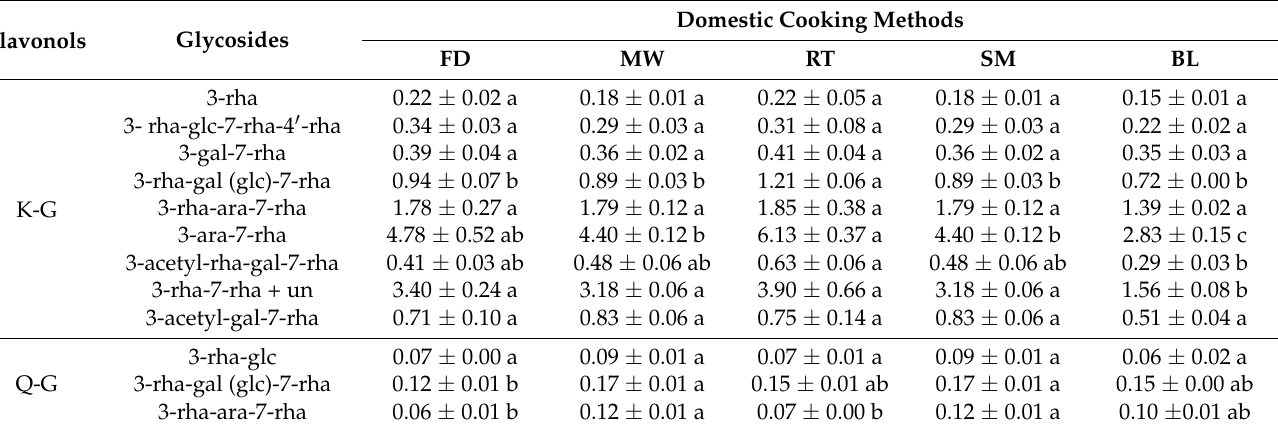
Table 2. Effect of domestic cooking on faba leaf flavonoid (flavonol) glycosides (mg of kaempferol-3- O -glucoside equivalent g − 1